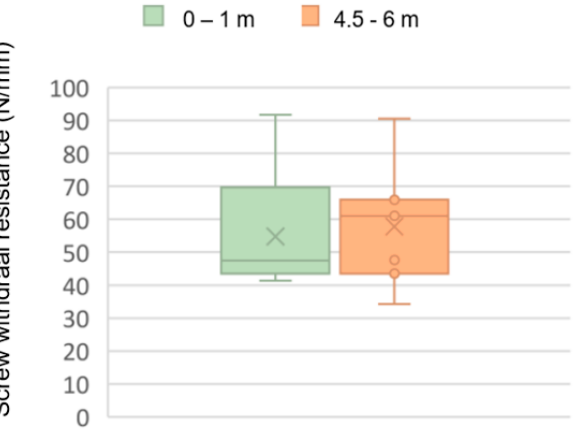
Figure 20. Screw withdrawal resistance of Paulownia samples extracted at 0–1 m and 4.5–6 m from the tree stem.